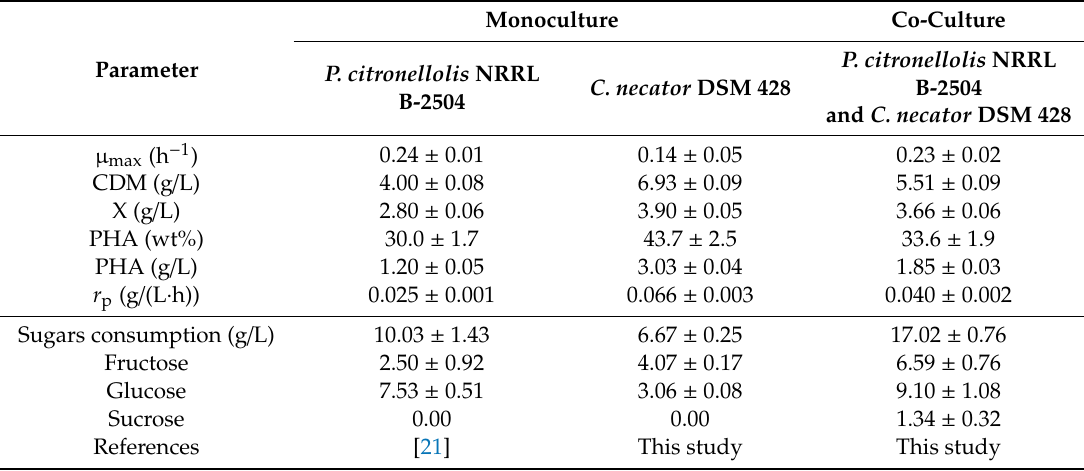
Table 1. Kinetic and stoichiometric parameters of the three batches produced by P. citronellolis NRRL B-2504, C. necator DSM 428, and the co-culture using apple pulp waste (CDM, cell dry mass; X, rest biomass; r p , volumetric